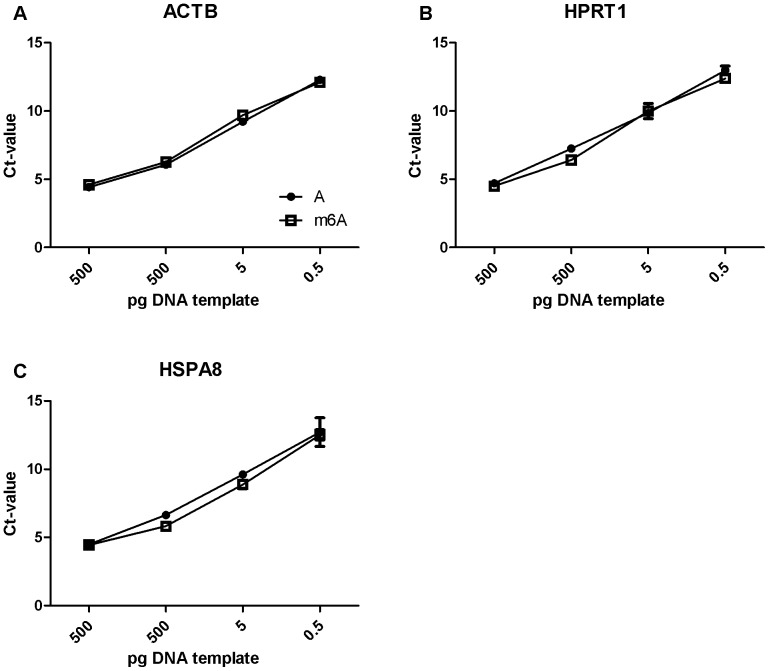
qPCR analysis of the effect of m6A on DNA amplification.qPCR analysis using different concentrations of the DNA templates ACTB (A), HPRT1 (B) and HSPA8 (C) containing m6A (open squares) or unmethylated adenosine (black circles) revealed that m6A does not interfere with DNA amplification.